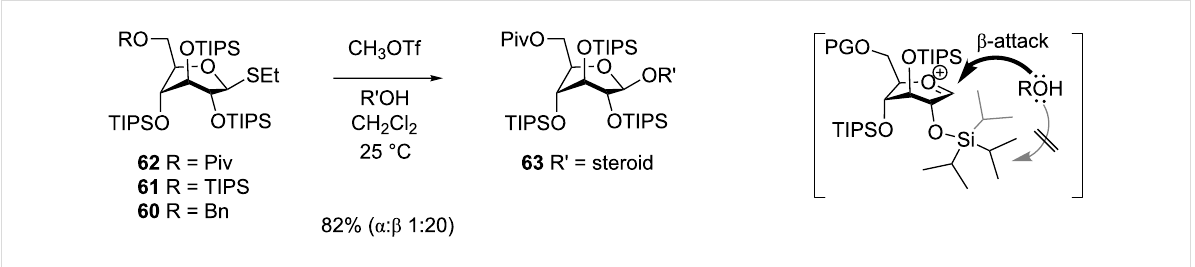
Scheme 11: β -Selective glucosylation with TIPS-protected glucosyl donors. The α -face is shielded by the bulky 2- O -TIPS protective group.